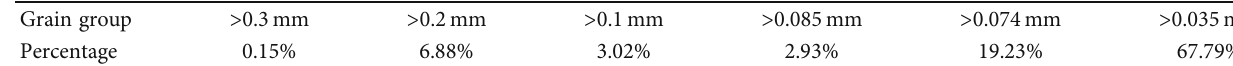
Figure 2: Two-dimensional radial fl ow device. (a) Equipment diagram, (b) equipment Table 1: Particle content of tailing sand used in the experiment.